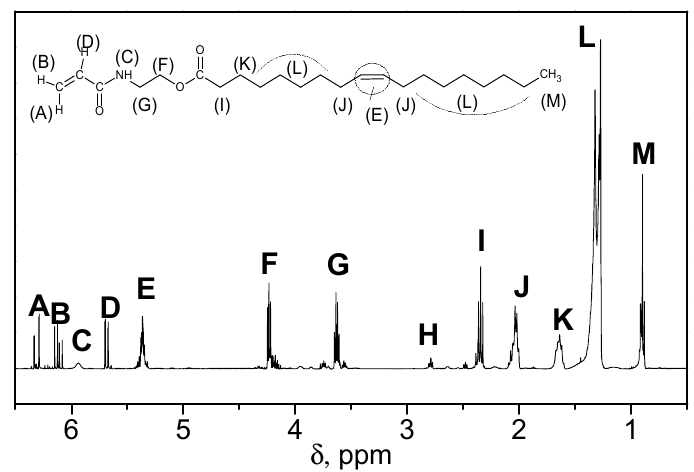
Figure 6. 1 H-NMR spectrum of the olive oil-based monomer. Adapted with permission from [12]. Copyright (2016) American Chemical Society.